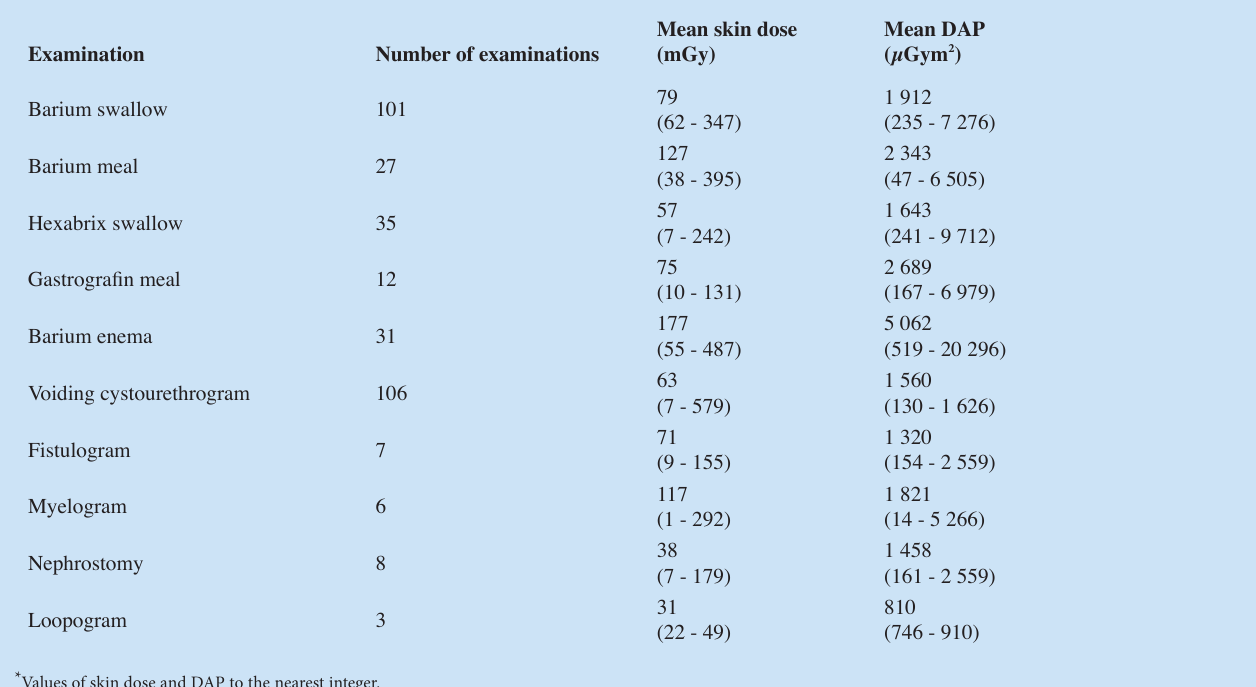
*Values of skin dose and DAP to the nearest integer.